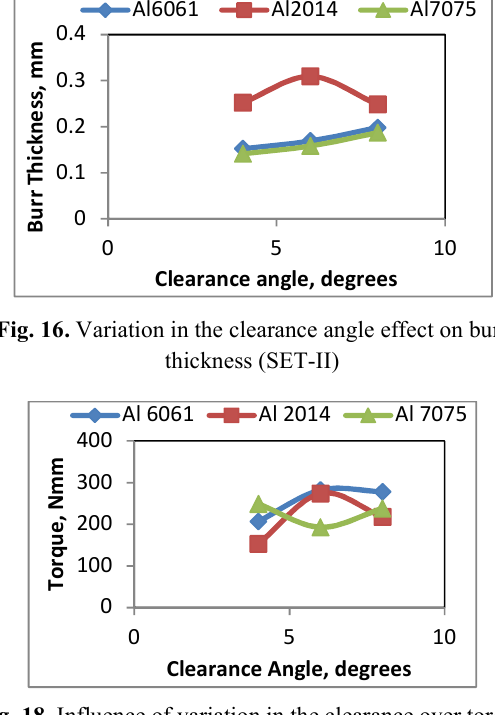
Fig. 18. Influence of variation in the clearance over torque